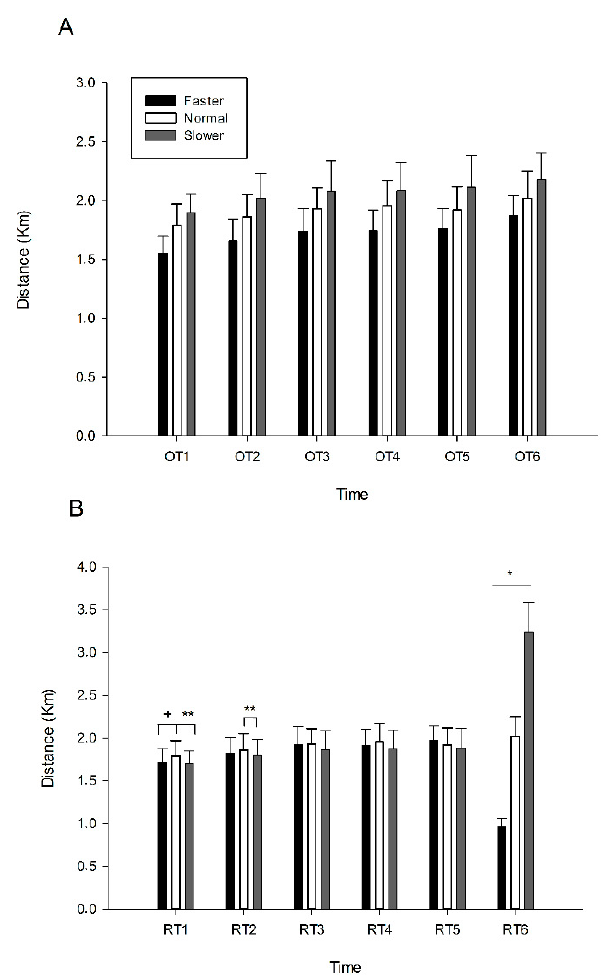
Figure 2. Distance (km) in the ( A ) observed Time (OT) and ( B ) real time (RT) analysis. Mean ( ± SD) data for distance for each condition with respect to ( A ) OT (every 10-min period of the observed time and ( B ) RT (every 10-min period of the real time). Notes: * Significant differences between the three conditions, ( p < 0.001) for all comparisons. + Significant differences between NC and FC ( p = 0.026) in T1. ** Significant differences between NC and SC in T1 ( p = 0.046) and T2 ( p = 0.032).